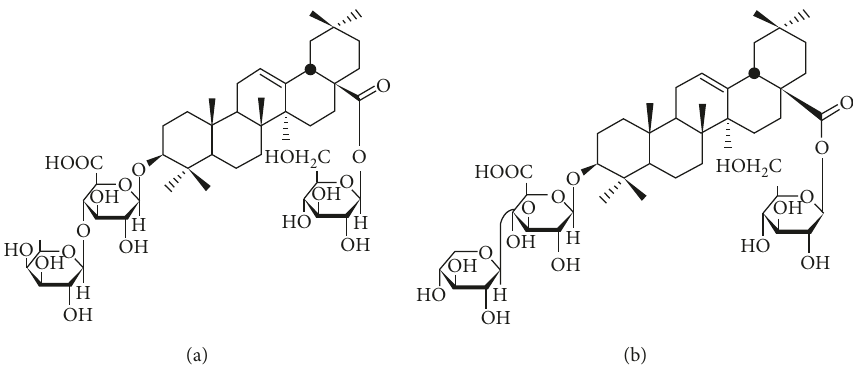
Figure 1: The structures of the saponins. (a) Chikusetsusaponin IV. (b) Momordin